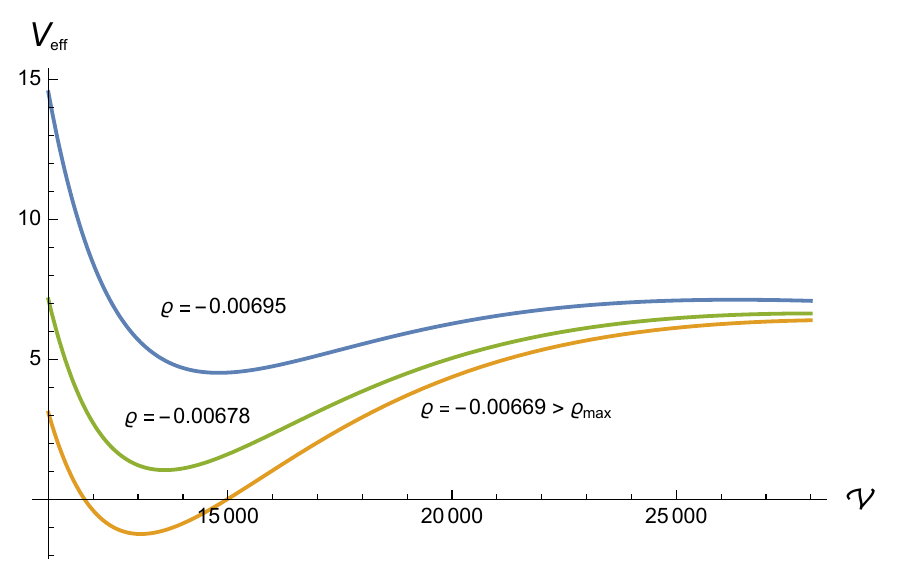
. The (cid:17)(cid:22) 6 W 2 0